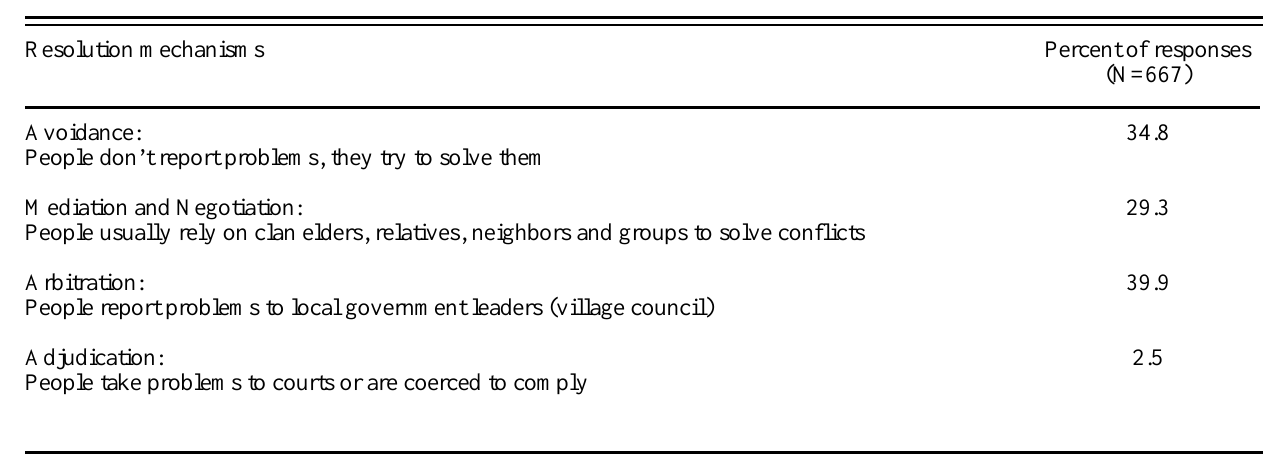
Table 3. Relative importance of conflict resolution